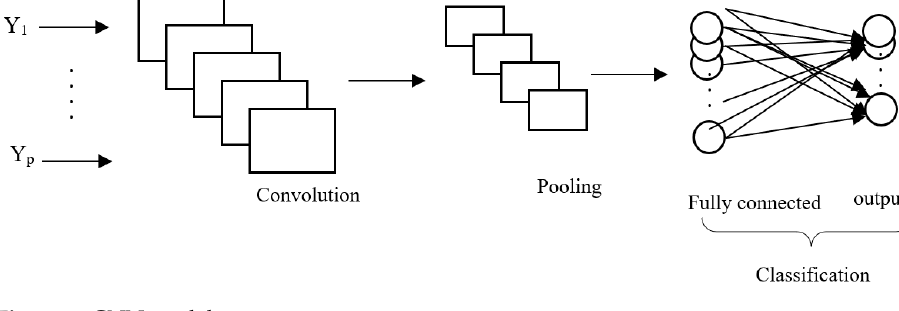
Figure 3. CNN model.